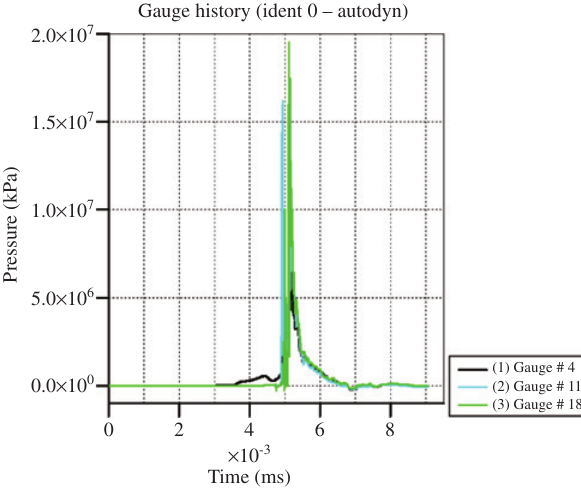
Figure 11: Pressure-time curve of points 4, 11,